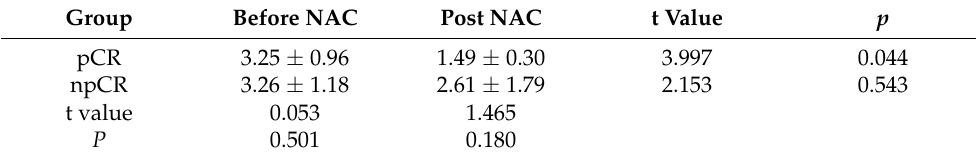
Table 2. The tumor to normal tissue (T/N) ratio values for the pCR and non-pCR groups.